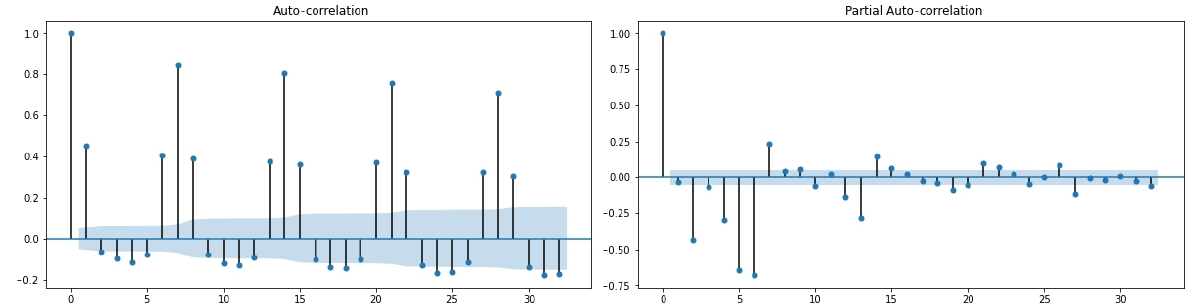
Figure 6. The ACF and PACF plots for total blood demand data.